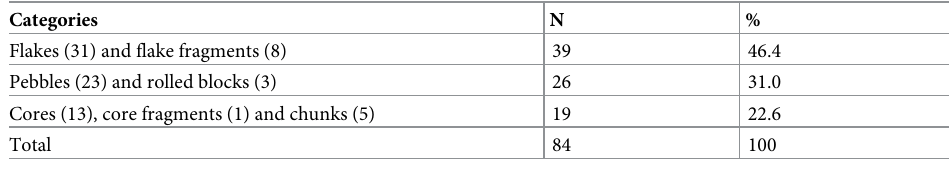
Table 7. Castel di Guido. Blanks of small tools �